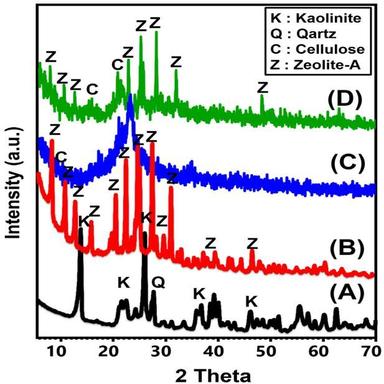
XRD patterns of kaolinite (A), synthetic zeolite-A (B), cellulose fibers (C), and synthetic CF/ZA composite (D).